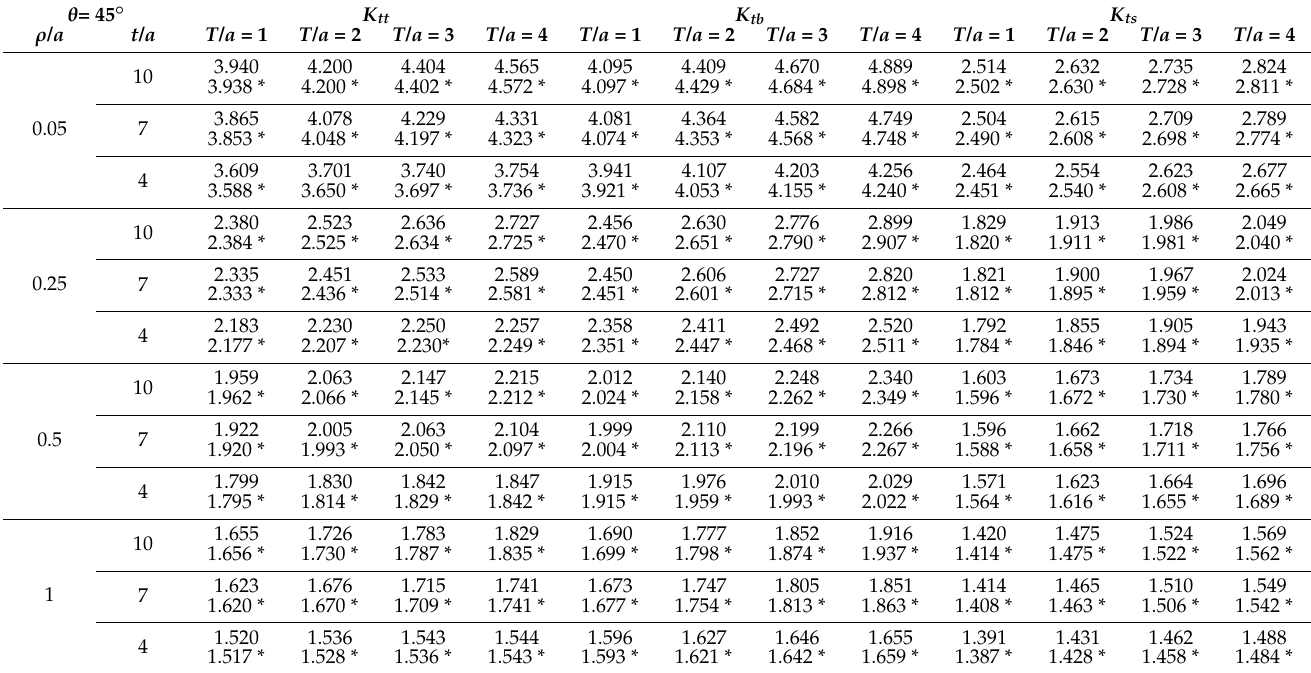
Table 6. Comparison of SCF’s values calculated using Equations (A1)–(A3) (*) to the corresponding FEM results for various T / a ratios, while θ = 45 ◦ .